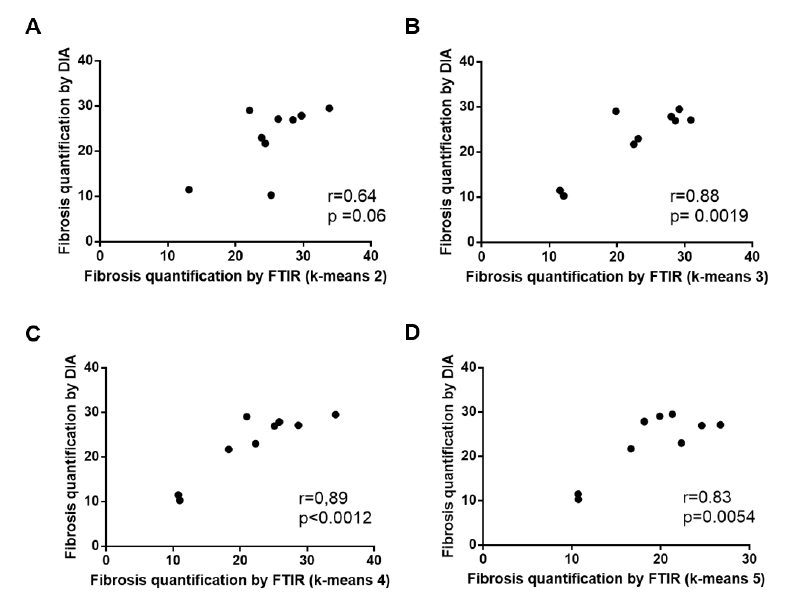
Figure 3. Correlations between fibrosis areas as measured by digital image analysis of histological sections after Masson’s trichrome staining and by k-means clustering of FTIR spectral images using 2, 3, 4 and 5 classes (( A – D ) respectively). An outlier point corresponding to a fibrosis area of 60–70% was excluded from the analysis (see text and Supplementary Figure S1).